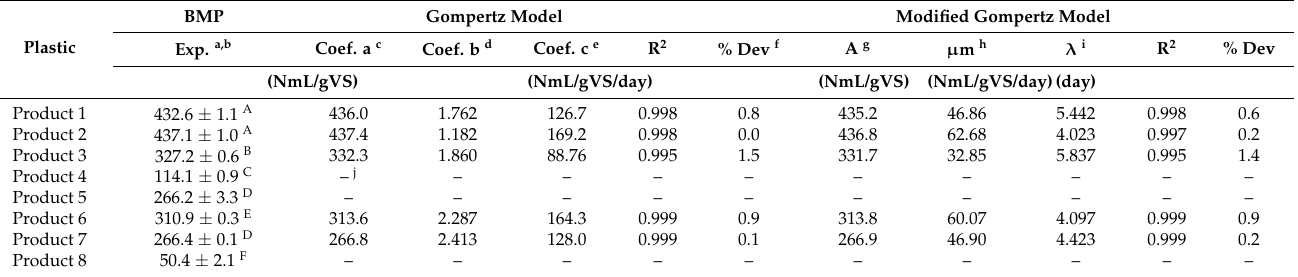
Table 7. The coefficients and parameters of the applied traditional and modified Gompertz models accomplished on the BMP